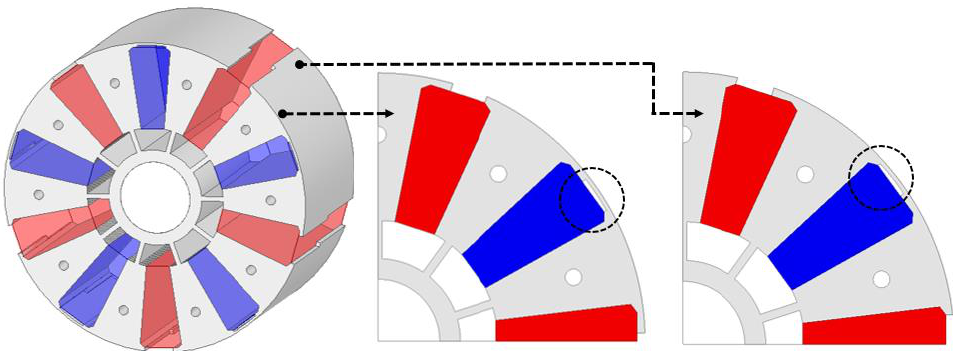
Figure 10. Rotor barrier asymmetric design and cross-laminated shape.